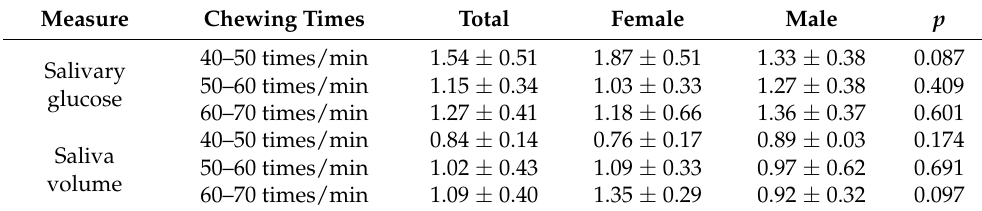
Table 2. Effects of chewing times on salivary glucose. (Unit: mmol/L).